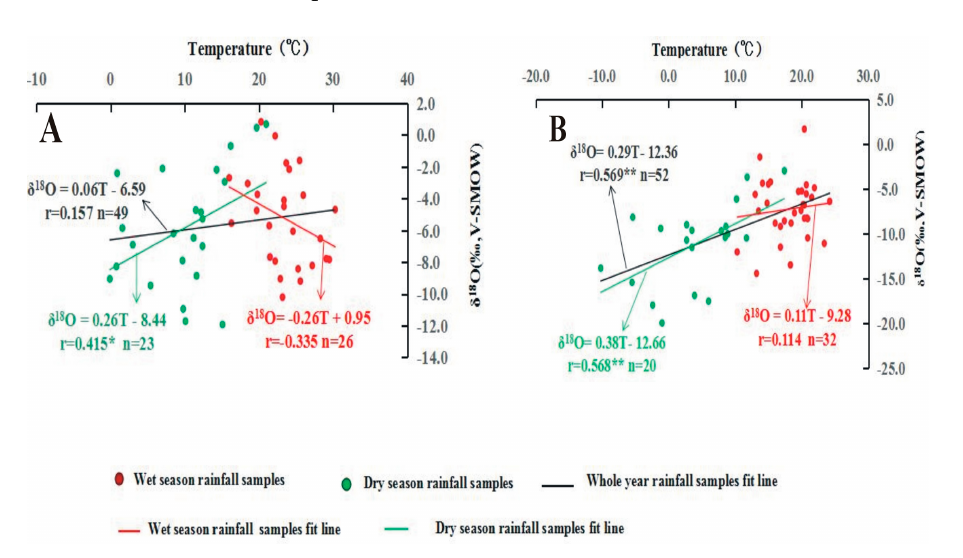
Figure 4. Relationship between δ 18 O precipitation and temperature. ( A , B ) represent Fengxiang and Ningwu, respectively. ** means a significant bilateral correlation at the 0.01 level; * means a significant bilateral correlation at the 0.05 level.